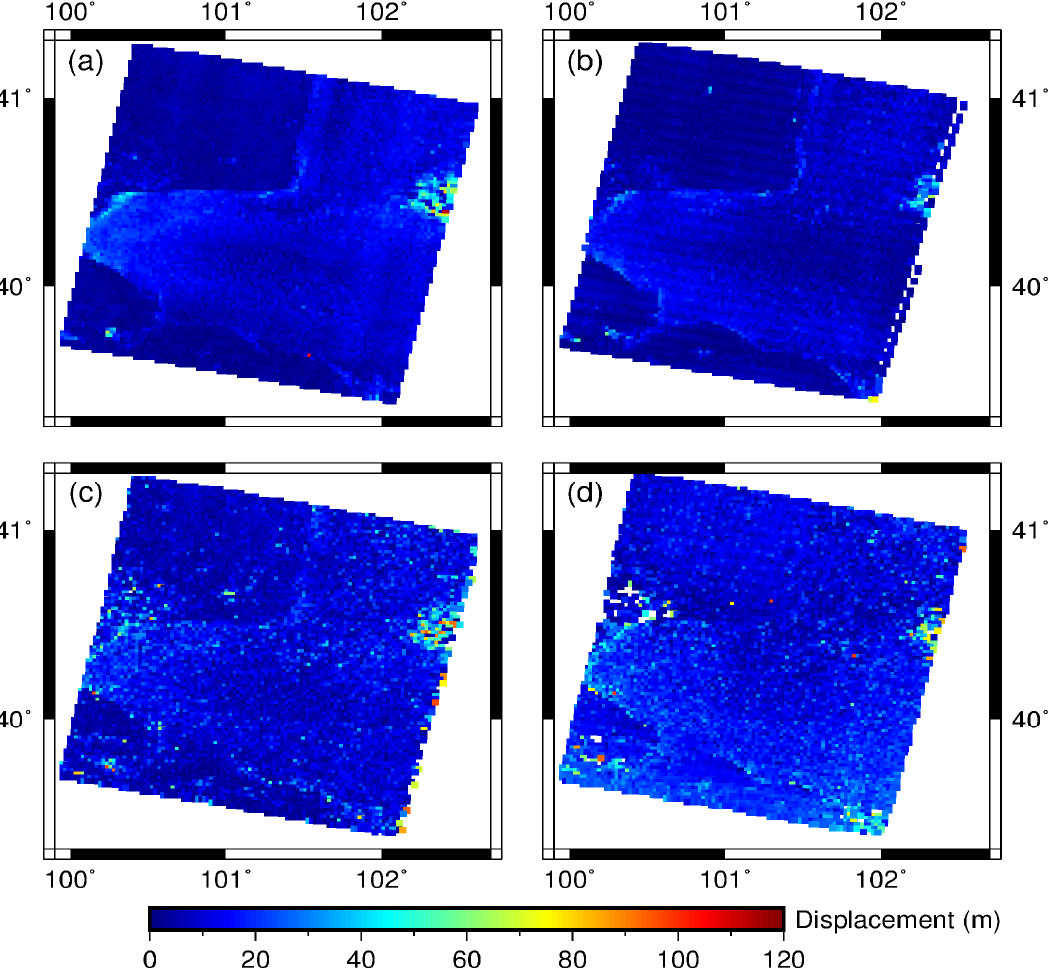
Figure 3. Displacement from 2005 to 2016: ( a , c ) Landsat 5 images were used as reference images, and ( b , d ) Landsat 7 SLC-off images were used as reference images; ( a , b ) images were processed using the DFT method, and ( c , d ) images were processed using COSI-Corr software. All of the results are unfiltered.